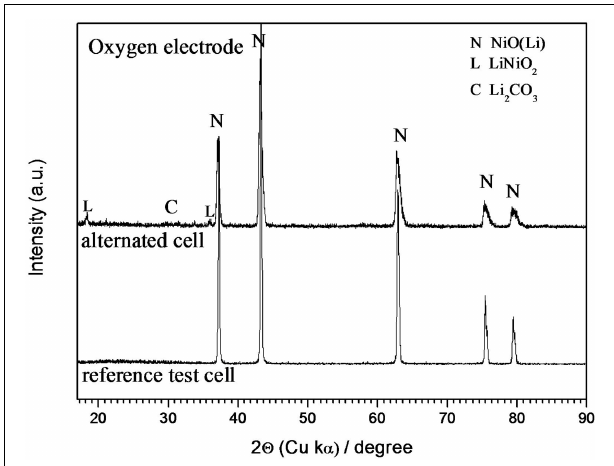
FIGURE 3 | XRD patterns of the spent NiO oxygen electrode in reverse and reference test MCFC cells.